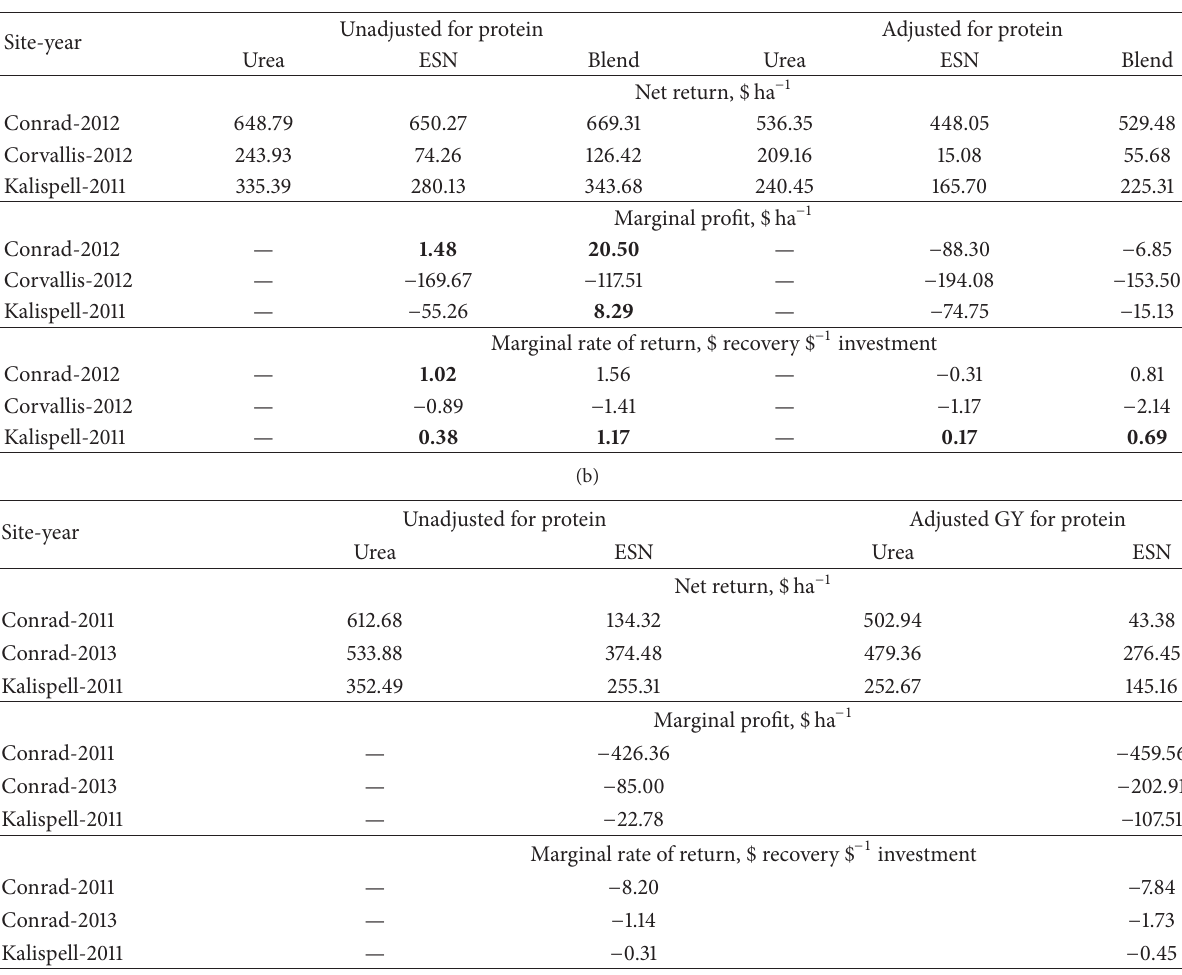
Table 8: (a) Protein-unadjusted and -adjusted revenues and marginal returns for selected site-years where grain yield was significant. (b) Protein-unadjusted and -adjusted partial budget analysis comparing medium at-seeding rate (112 and 224 N kgha −1 at Conrad and Kalispell, resp.) and low at-seeding rate (56 and 112kg ha −1 at Conrad and Kalispell, resp.) along 45 kg ha −1 topdress N rates for selected